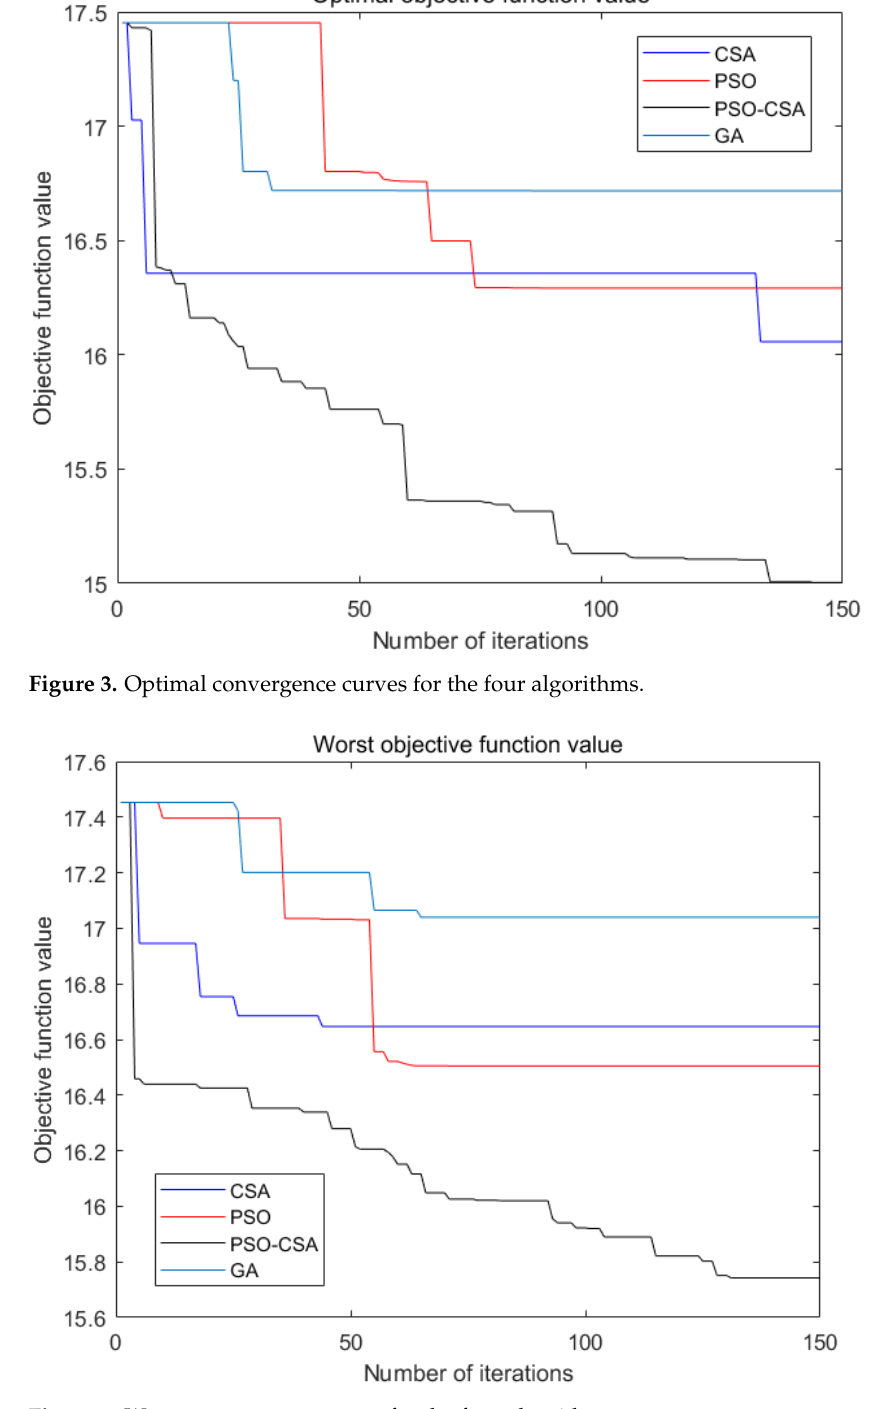
Figure 4. Worst convergence curves for the four algorithms.